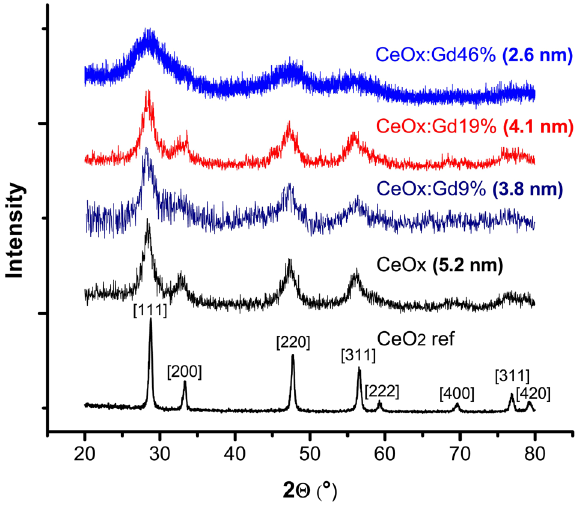
Figure 3. X-ray diffractograms of three CeNPs samples (CeOx, CeOx:Gd9%, CeOx:Gd19% and CeOx:Gd46%) and one reference sample of cerium oxide nanopowder (CeO 2 ref). The calculated grain sizes of the [220] peak from the Scherrer equations are